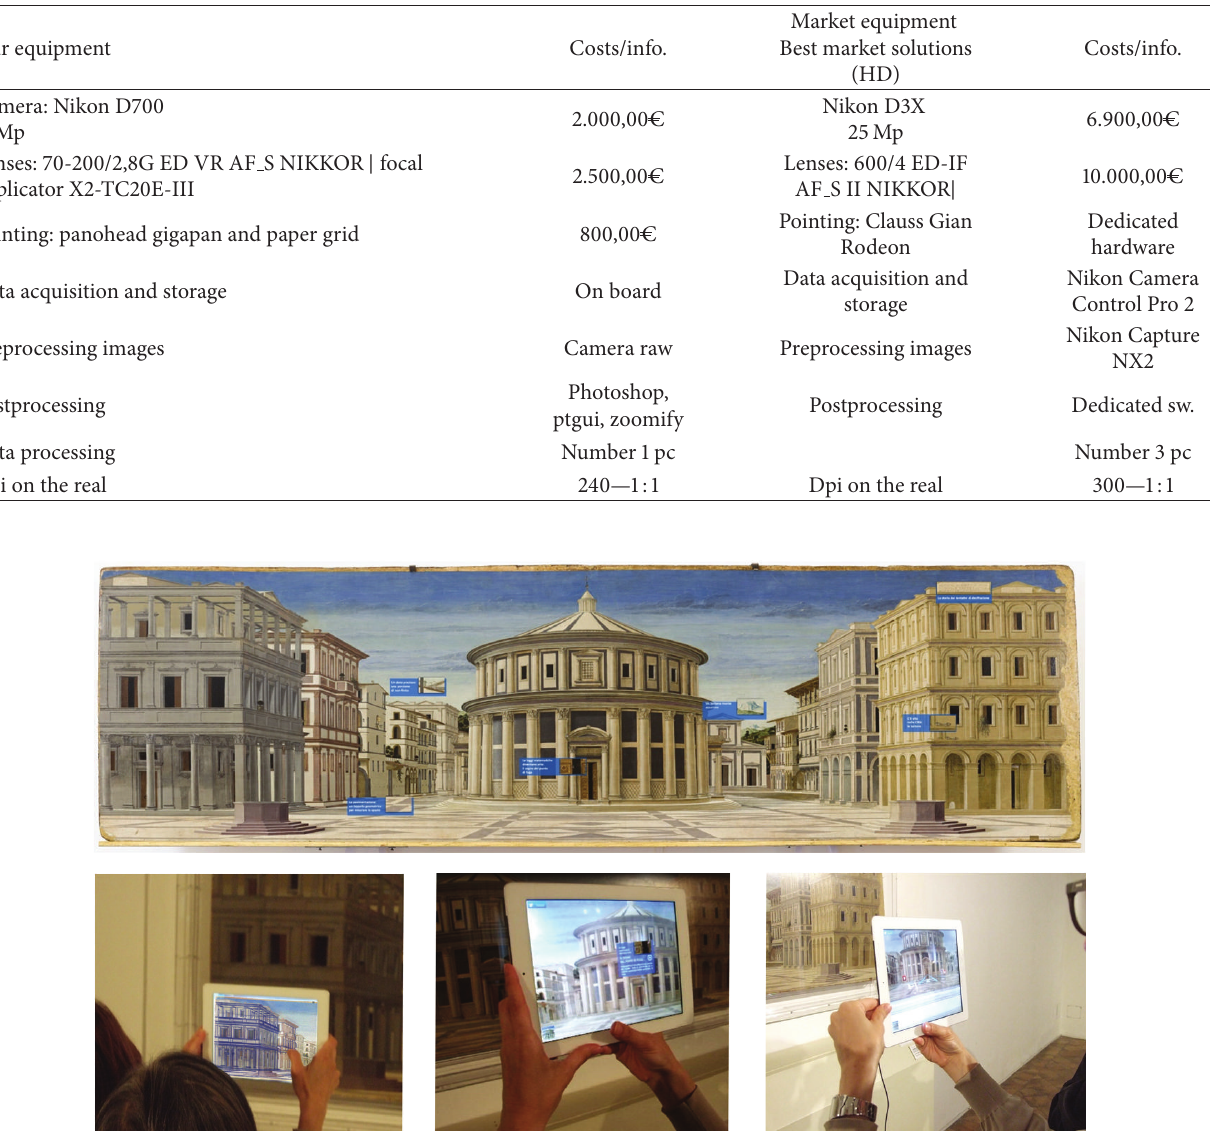
Table 2: Equipment for HD acquisition and comparison with market solution.